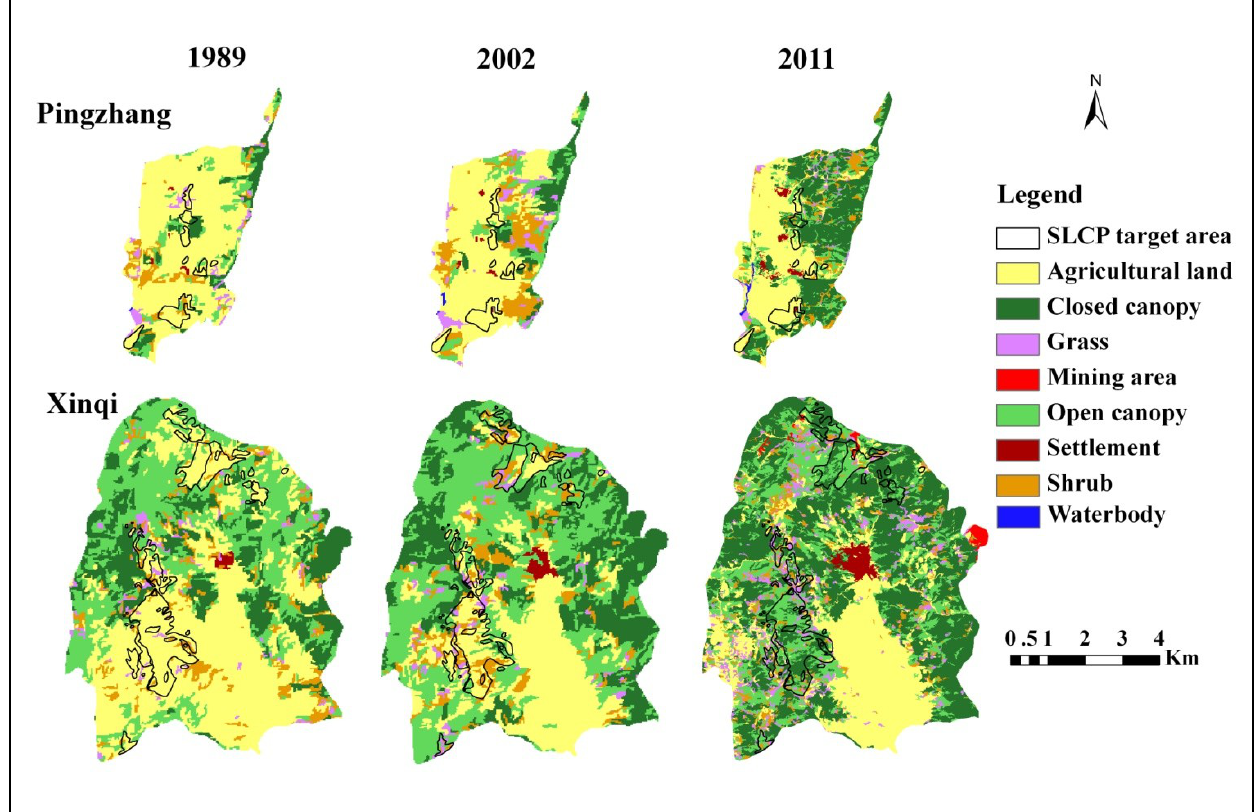
Figure 2. Land use and change in Pingzhang and Xinqi in 1989, 2002 and